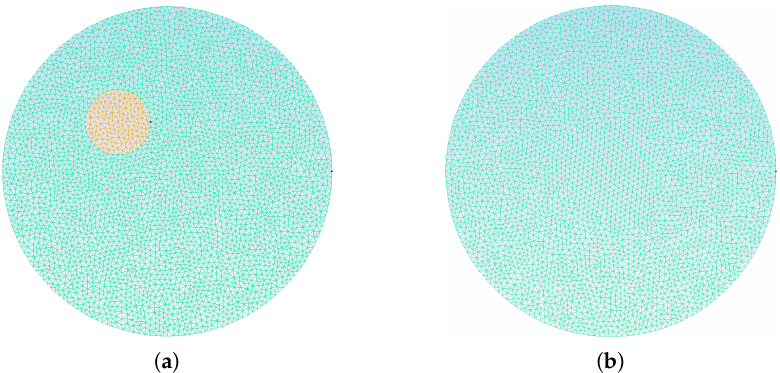
Figure 1. The mesh used in numerical examples: ( a ) the mesh of forward model and ( b ) the mesh of inverse problem.